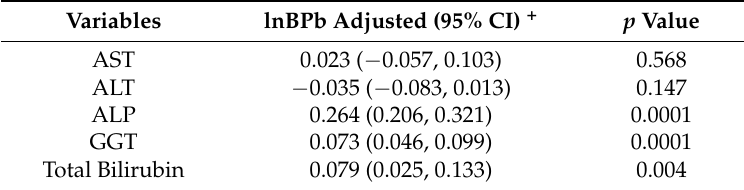
Table 5. Associations of BLL hepatobiliary-related markers of interest.